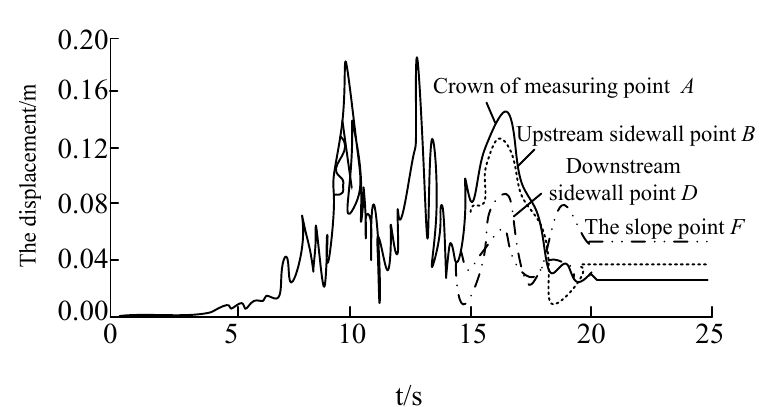
Figure 4: Displacement time history curve of dynamic calculation process